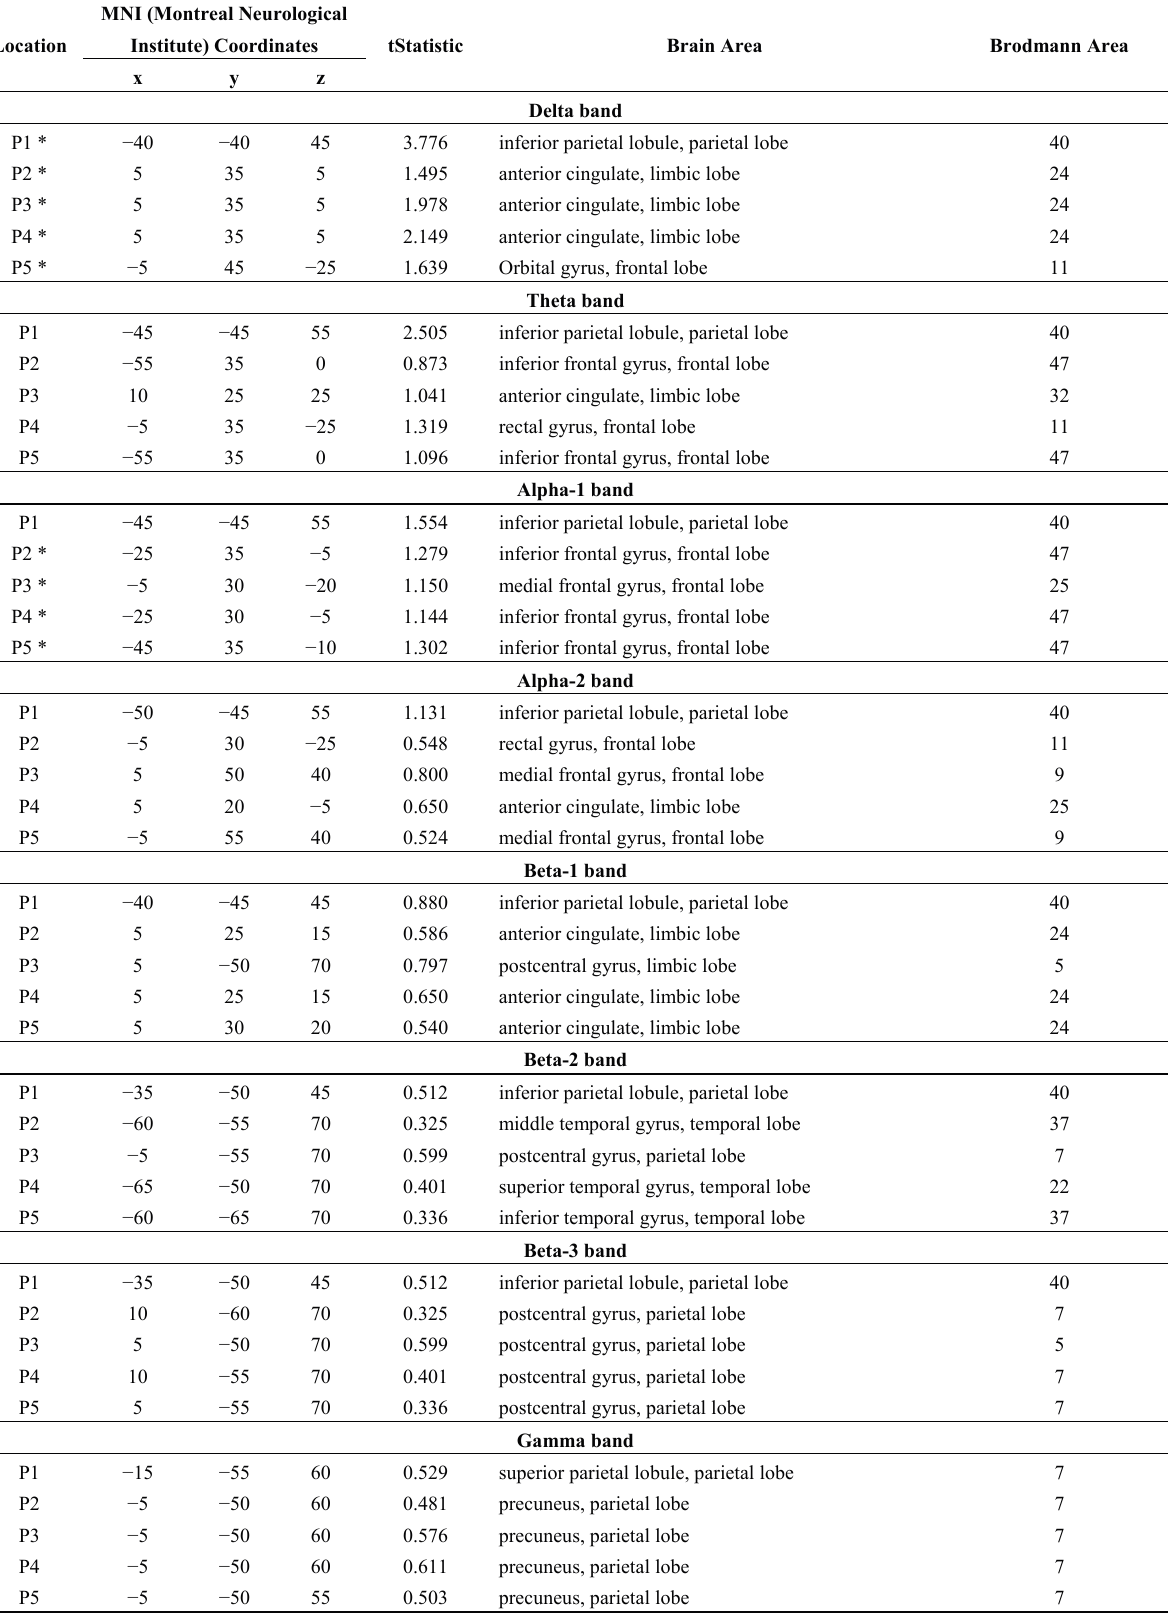
Table 3. Brain activation areas in discrete frequency bands (* a statistically-significant difference is found between the veridical and illusory